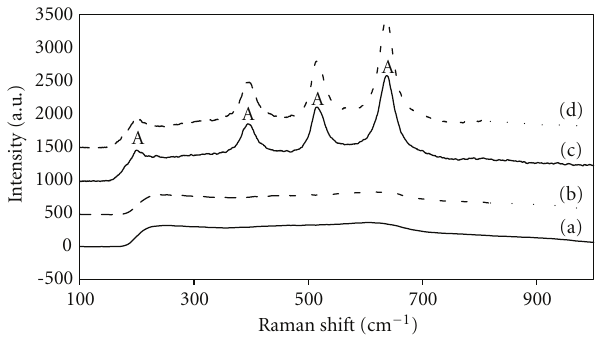
Figure 6: Raman spectra of (a) as-anodized TiO 2 nanotube arrays fabricated at 40 ◦ C, (b) as-anodized TiO 2 nanotube arrays fabricated at 60 ◦ C, (c) annealed TiO 2 nanotube arrays fabricated at 40 ◦ C, and (d) annealed TiO 2 nanotube arrays fabricated at 60 ◦ C (A: